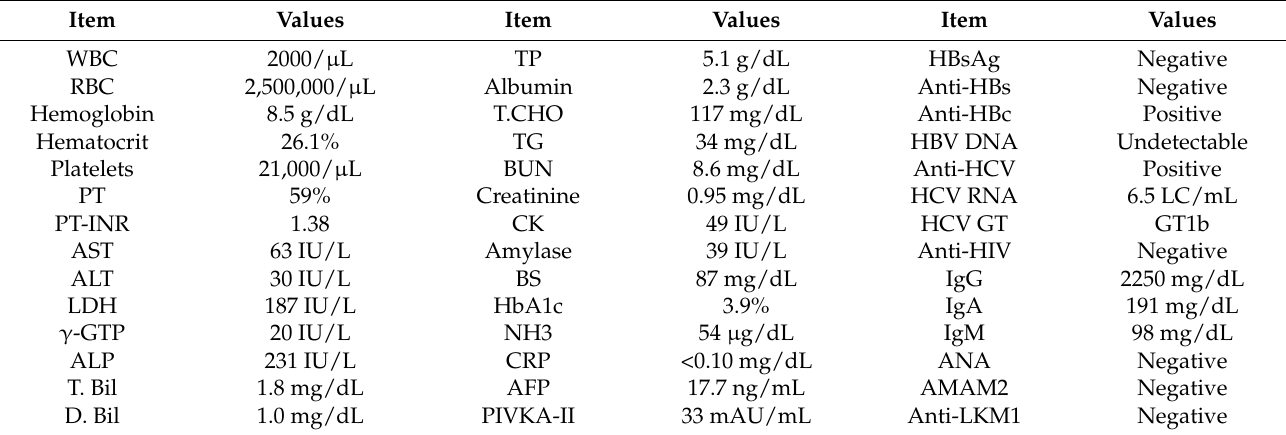
Table 1. Laboratory data of recipient before living-donor liver transplantation